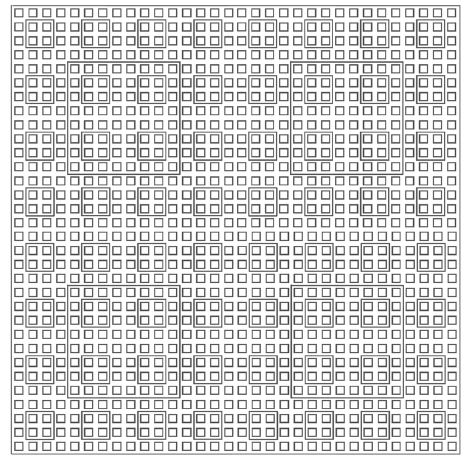
Fig. 1 | Tiling pattern for the classical ground state ∣ T i c . Encoding the ground state of the classical Hamiltonian into Robinson tiles generates a quasi-periodic pattern of nested squares. History states are then placed along the top edge of every square in the